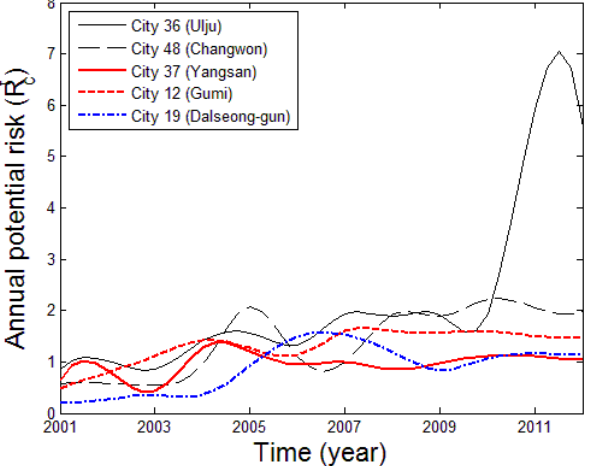
Figure 7. Variation of annual potential risk ( R t c ) for five cities in the Nakdong River